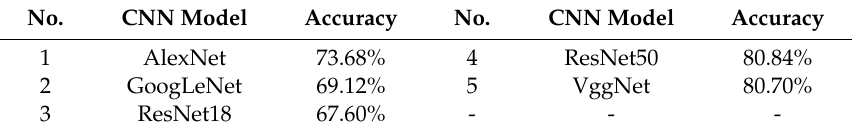
Table 3. Comparison of the classification accuracy of several mainstream CNN models of